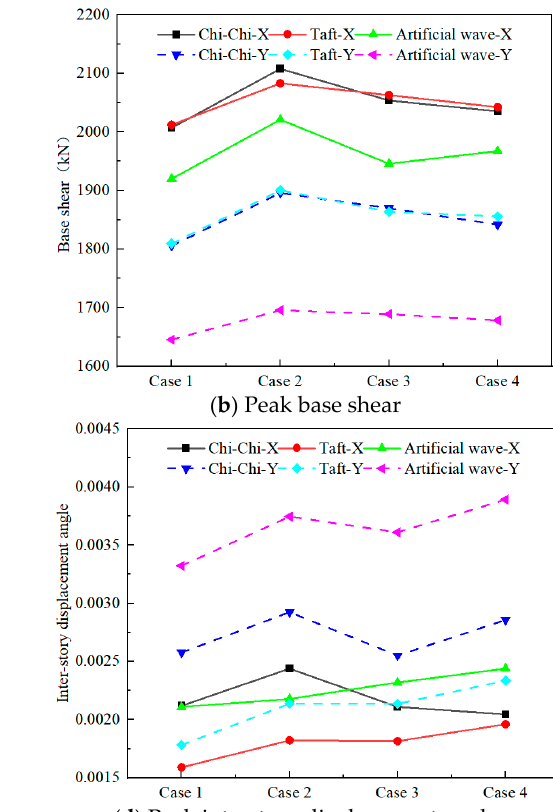
Figure 10. Results of frequent-earthquake time-history analysis.